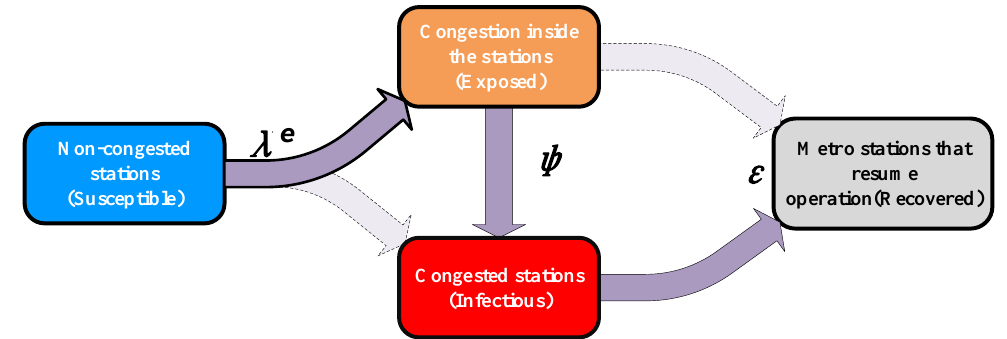
Figure 6. Congestion propagation process in the metro network using the ASEIR model.